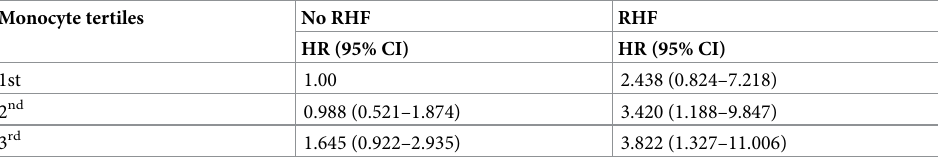
Risk are adjusted by age, sex, systolic blood pressure, body mass index, estimated glomerular filtration rate, fasting glucose, hemoglobin, aspartate transaminase, aspartate aminotransferase, alkaline phosphatase, total cholesterol, diabetes, hypertension, coronary artery disease, and